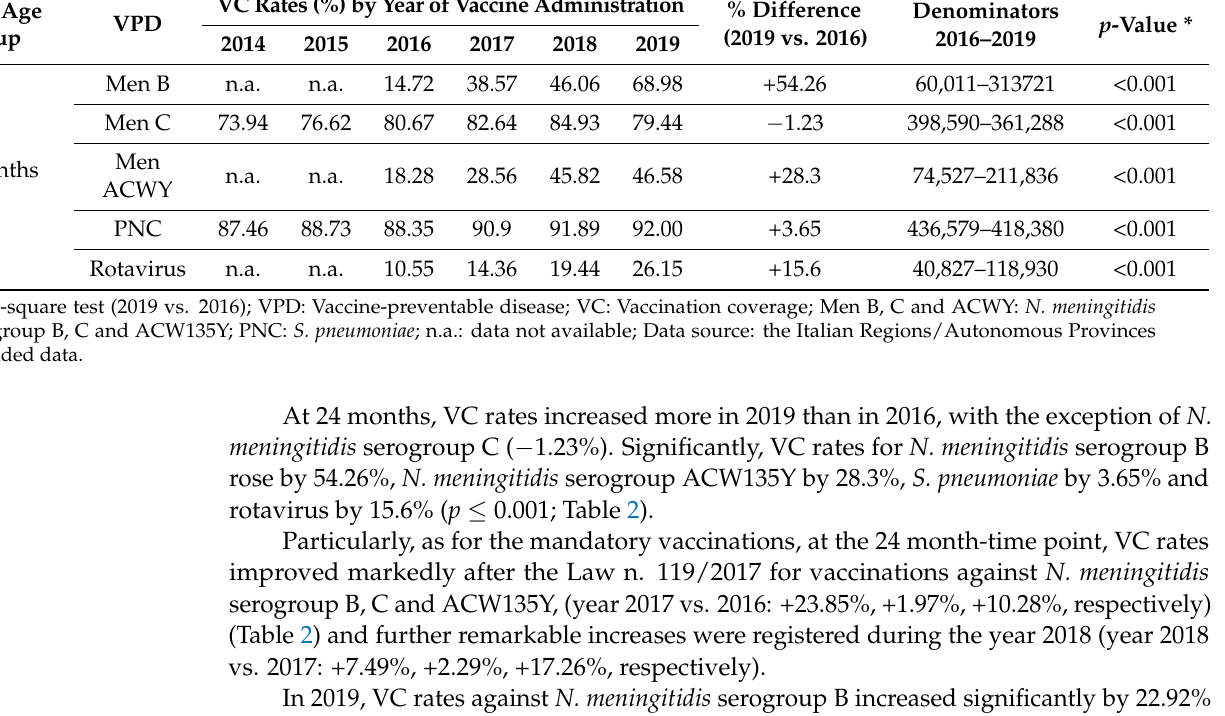
Table 2. Vaccination coverage (VC) rates (%) registered for the recommended vaccinations at 24 months of age, stratified by vaccine and year of administration, along with the percentage differences between 2019 and 2016 rate. Italy 2014 to 2019. VC Rates (%) by Year of Vaccine Target Age VPD Group